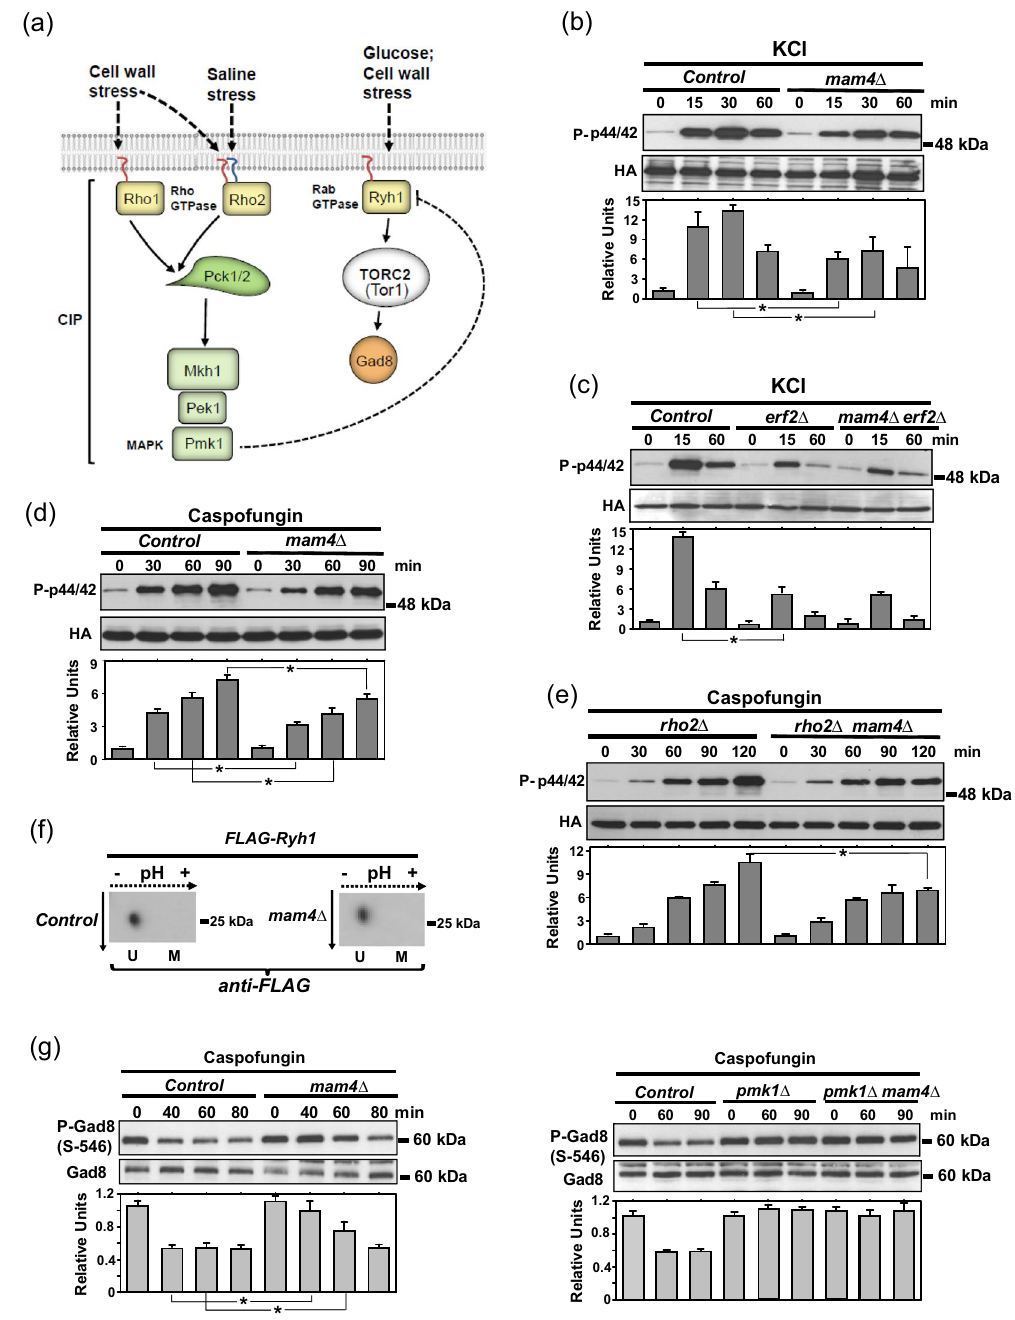
Figure 5. Mam4 positively regulates signaling and activation of the cell integrity pathway (CIP) elicited by Rho1 and Rho2, and cross-inhibition of TORC2 signaling. ( a ) Activation of the main CIP effector, MAPK Pmk1, in response to saline stress is totally dependent on the activity of palmitoylated Rho2, whereas MAPK activation in response to cell wall stress is channeled through Rho1 and Rho2. In turn, activated Pmk1 negatively regulates Ryh1-TORC2-Gad8 signaling. ( b ) Growing cultures of control and mam4 Δ strains expressing genomic Pmk1-HA6H fusions were treated with 0.6 M KCl for the indicated times. Pmk1-HA6H fusion was purified by affinity chromatography, and activated/total Pmk1 detected with anti-phospho-p44/42 and anti-HA antibodies, respectively. Relative units as mean ± SD for Pmk1 activation (biological triplicates) were determined with respect to the internal control (anti-HA blot) at each time point. * P < 0.05. ( c ) Growing cultures of control erf2 ∆ , and mam4 ∆ erf2 ∆ strains expressing genomic Pmk1-HA6H fusions were treated with 0.6 M KCl, and activated/total Pmk1 was detected and quantified as described in ( b ). * P < 0.05. ( d ) Growing cultures of control and mam4 Δ strains expressing genomic Pmk1-HA6H fusions were treated with 1 μ g/ml Caspofungin, and activated/total Pmk1 was detected and quantified as described in ( b ). * P < 0.05. ( e ) Growing cultures of rho2 Δ and rho2 ∆ mam4 ∆ strains expressing genomic Pmk1-HA6H fusions were treated with 1 μ g/ ml Caspofungin, and activated/total Pmk1 was detected and quantified as described in ( b ). * P < 0.05. ( f